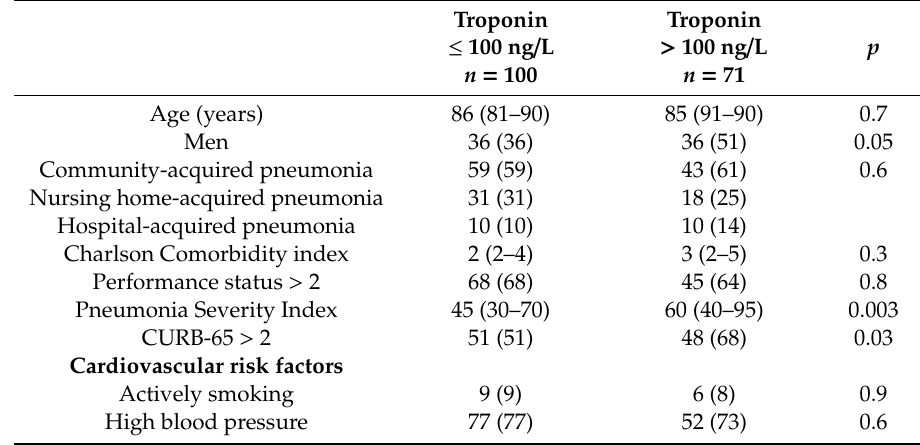
Table 1. Characteristics at admission of older in-patients with acute pneumonia ( n (%) or median (interquartile